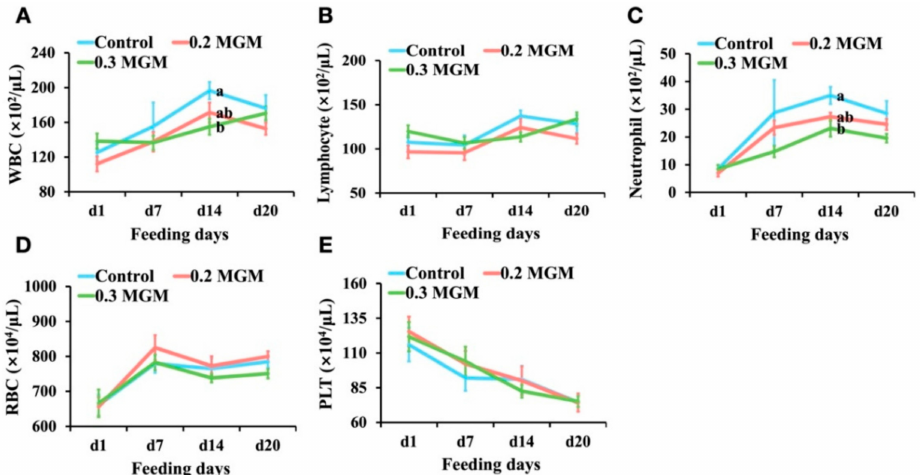
Figure 2. Effects of MGM-P supplementation on blood hematology parameters in weaned piglets. Blood was collected on d1 before the provision of feed with MGM-P on the day of weaning. Values are expressed as mean ± SEM; n = 8. Different lowercase letters on the right side of the nodes indicate significant differences ( p < 0.05; Tukey HSD test). ( A ) the changes of the white blood cell count; ( B ) the changes of the lymphocyte count; ( C ) the changes of the neutrophil count; ( D ) the changes of the red blood cell count; ( E ), the changes of the platelet